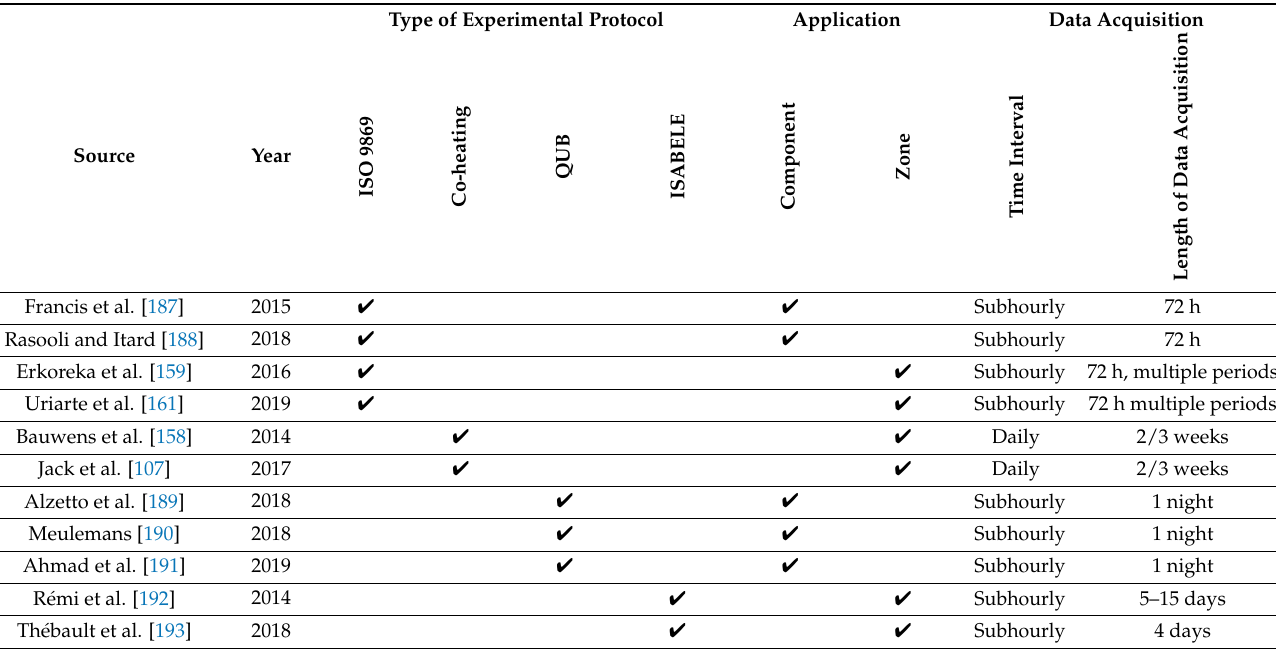
Table 5. Experimental protocols and